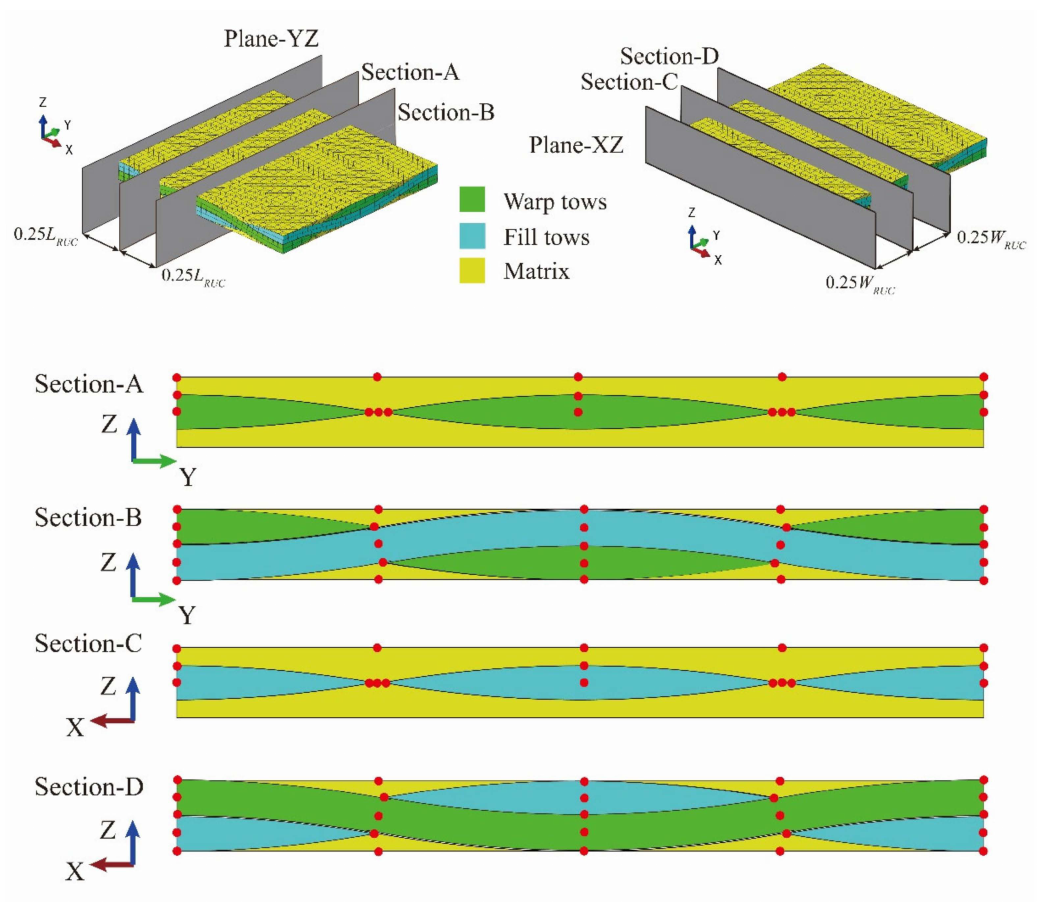
Figure 4. Reference points in the meso-scale